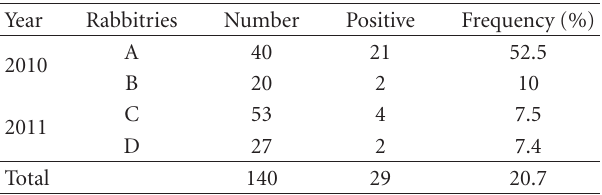
Table 1: Frequency of positive animals in four rabbitries